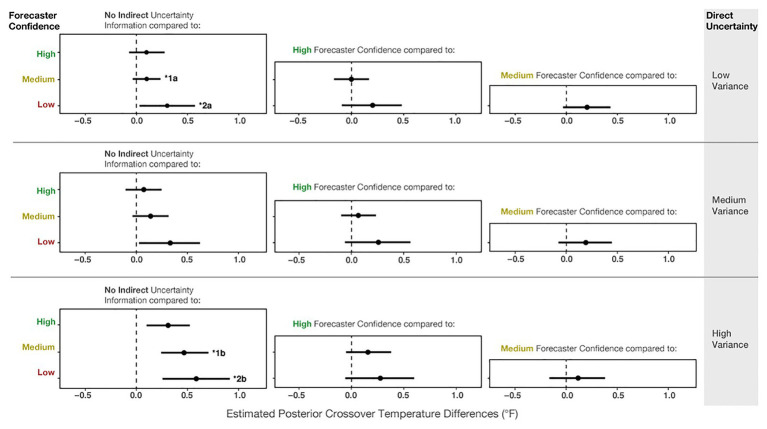
The 95% credible intervals for the comparisons between each forecast confidence condition.